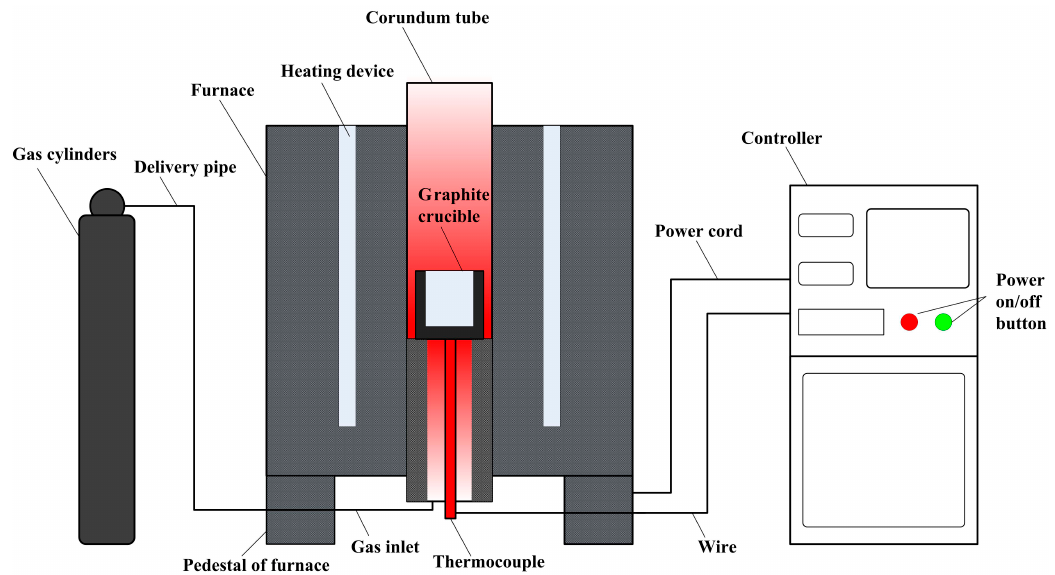
Figure 2. The SG-160-MoSi 2 furnace in the Figure 2. The SG ‐ 160 ‐ MoSi 2 furnace in the laboratory.